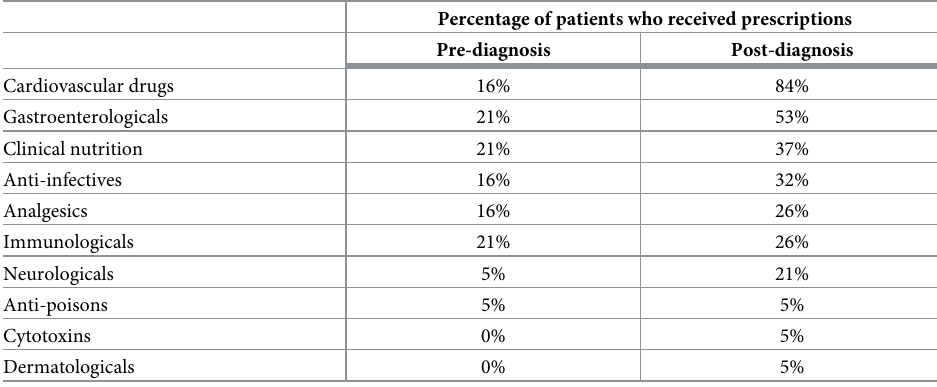
Table 5. Patients who received prescriptions for drugs and clinical nutrition.